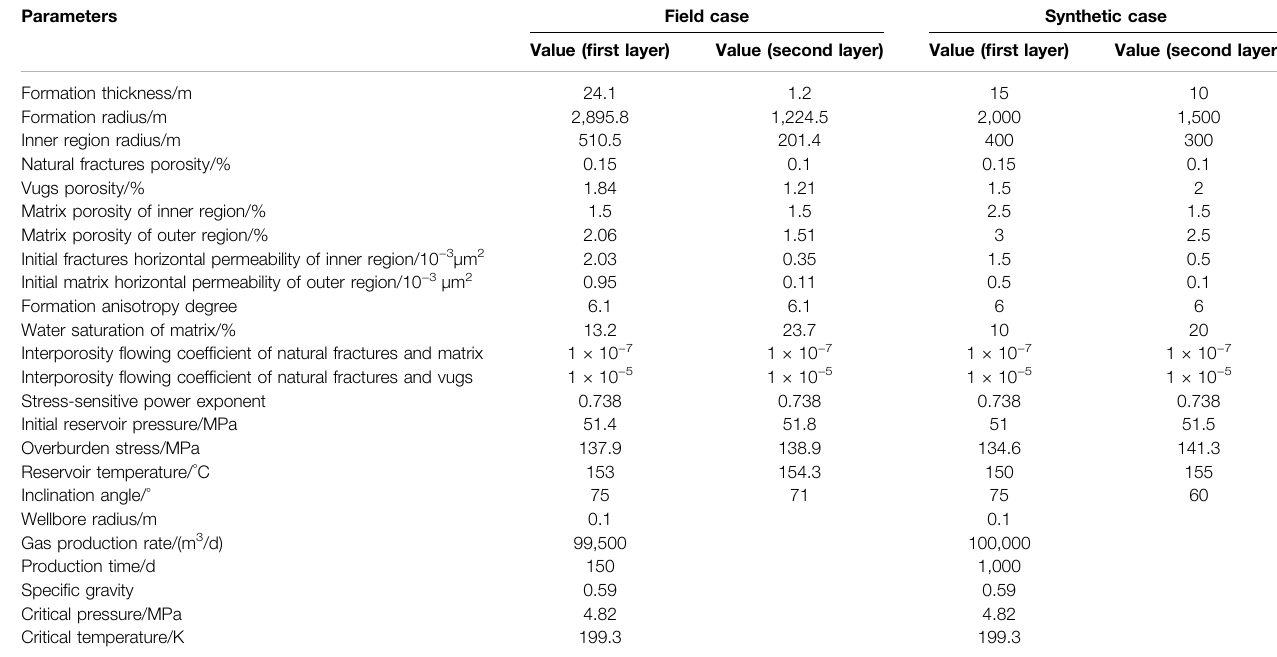
TABLE 2 | Reservoir, fl uids, and production data applied on the fi eld and synthetic cases.